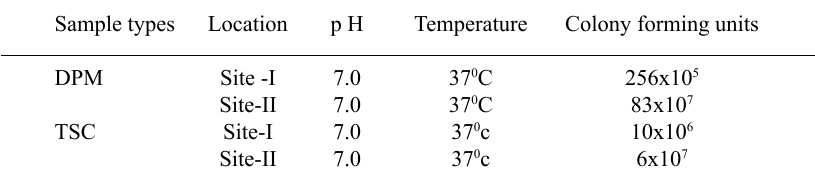
Fig. 3. Effect of copper on bacterial growth (OD at table 2. Microbial count of the industrial soil samples